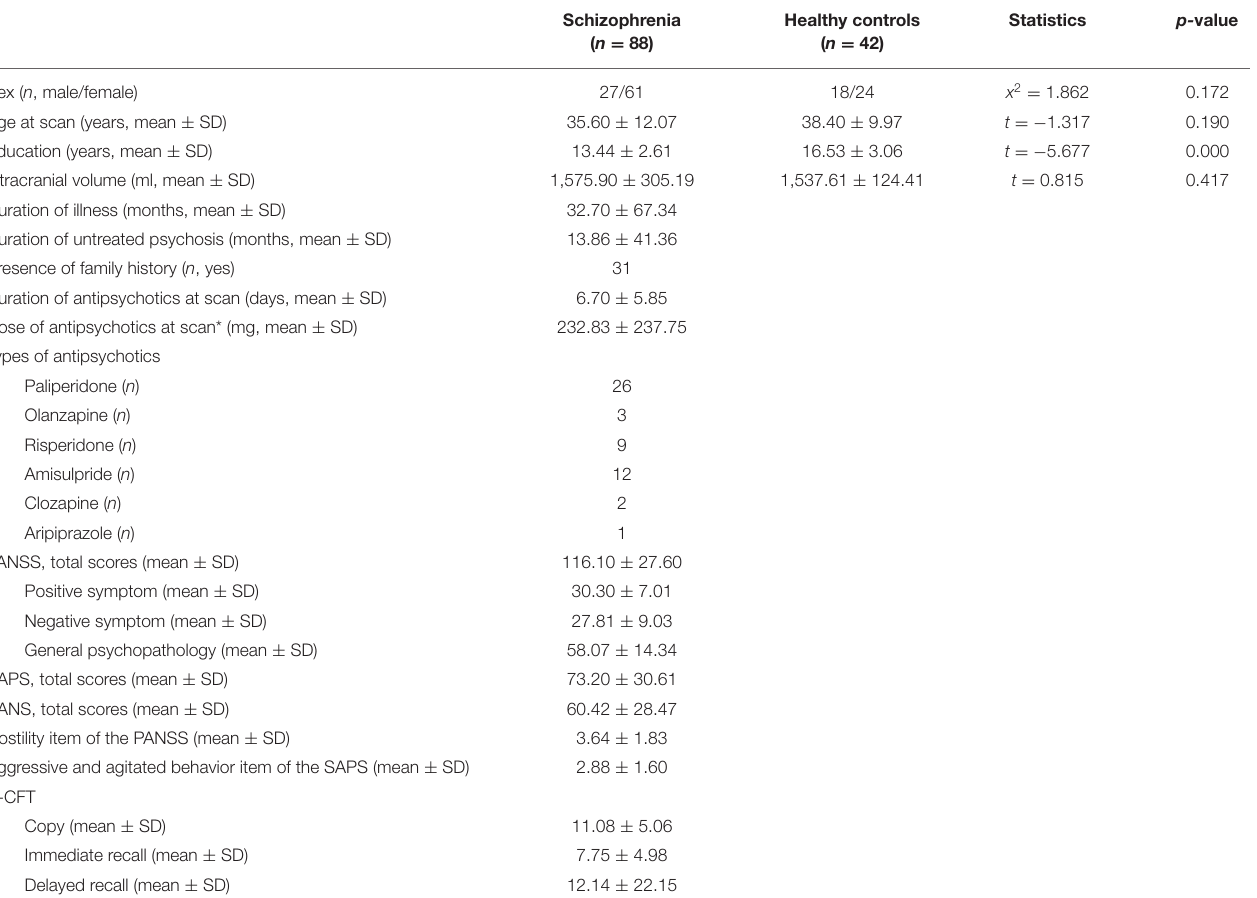
TABLE 1 | Sociodemographic and clinical characteristics of participants with schizophrenia and healthy